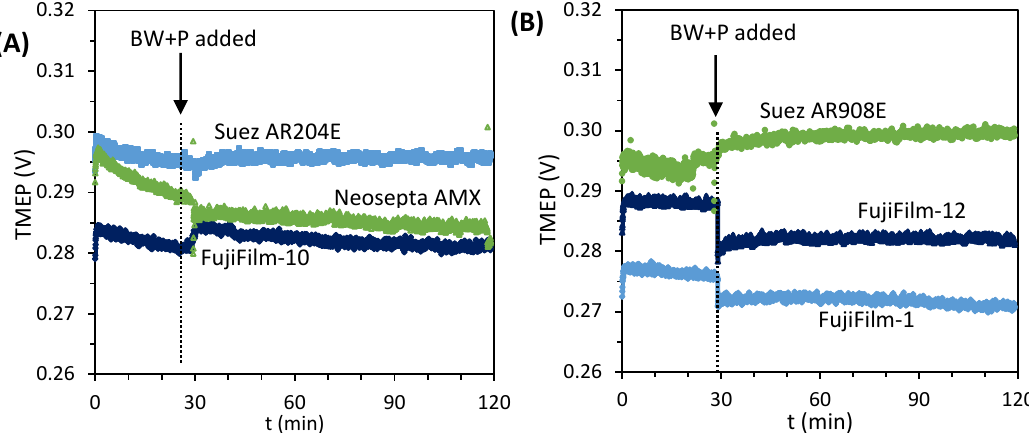
Figure 8. Measured transmembrane electric potential (TMEP) vs. time for fouling experiments in the six-compartment cell. BW was desalinated at 28 A / m 2 for 30 min, after which the feed was substituted by the BW + P solution. Plot ( A ) presents results for Neosepta AMX, Suez AR204E, and FujiFilm-10, while plot ( B ) includes Suez AR908E, FujiFilm-1, and FujiFilm-12. The jumps in TMEP are caused by small variations in the conductivity of the solution.